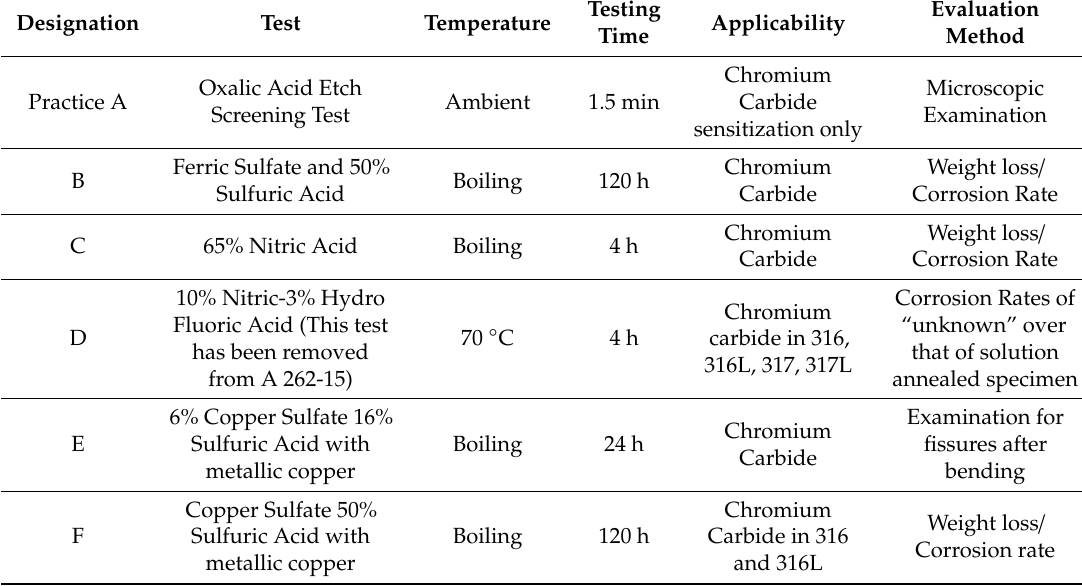
Table 4. ASTM A262-15 [36] Standard practice for detecting susceptibility to intergranular attack in austenitic stainless